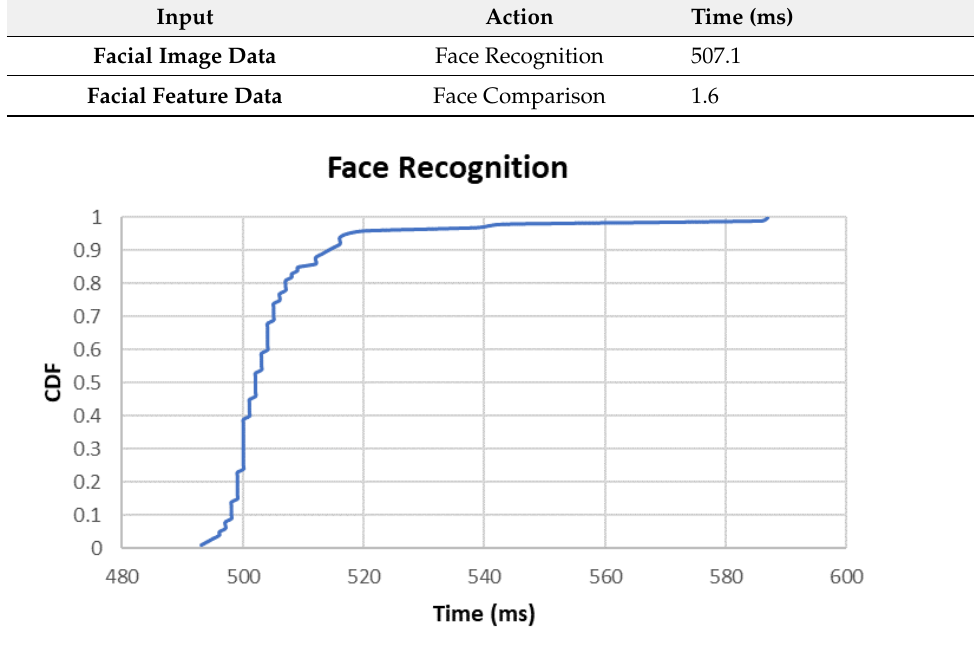
Table 6. Overhead of TA in Processing Facial Recognition.